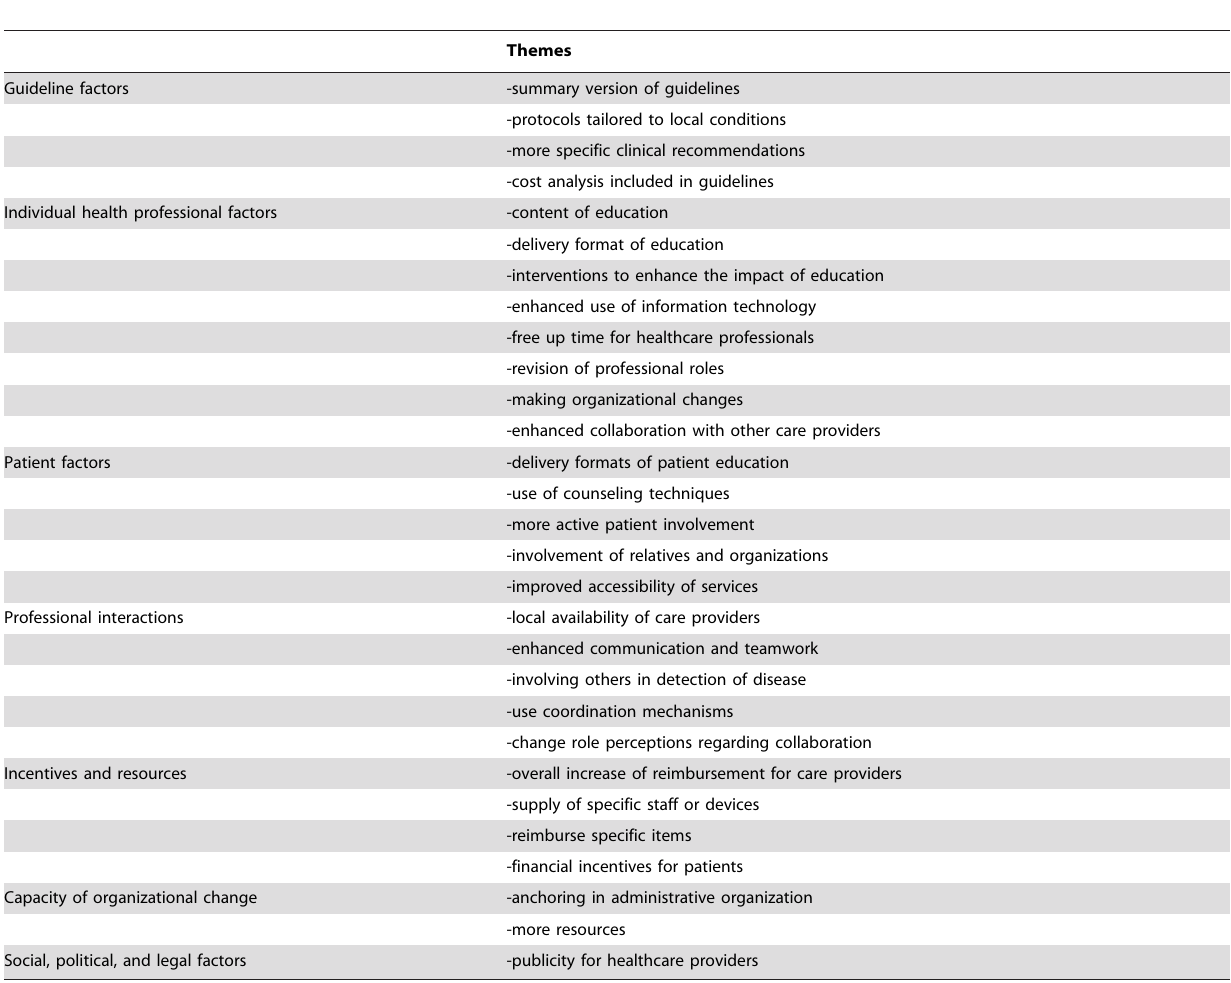
Table 4. Summary of themes in the items for improving healthcare, mapped onto TICD framework